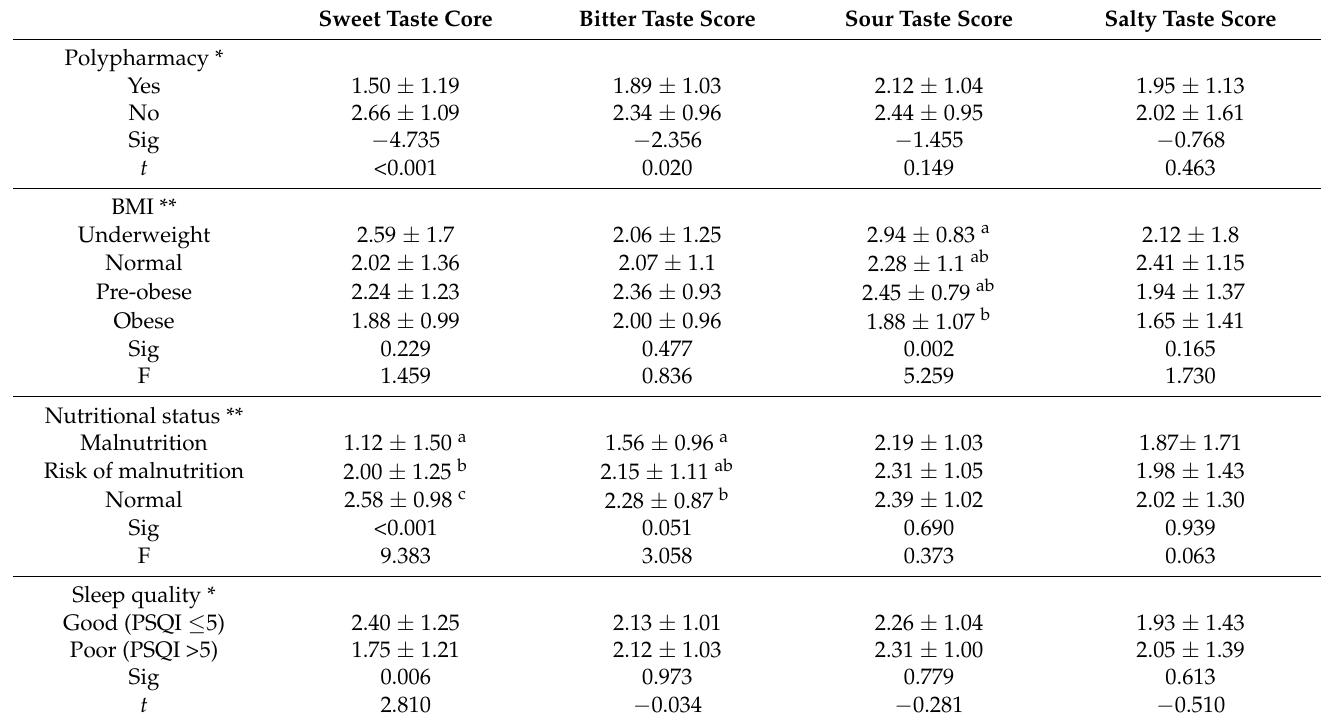
Table 2. Comparison of gustatory functions in older participants in terms of BMI classification, polypharmacy, nutritional status, and sleep quality.